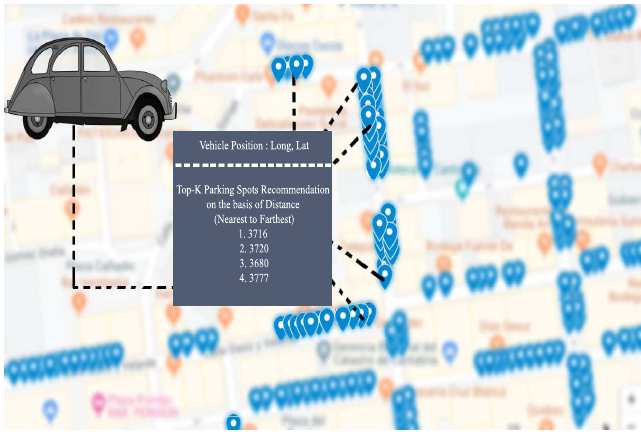
Figure 10. Recommending top-K parking spots on the basis of